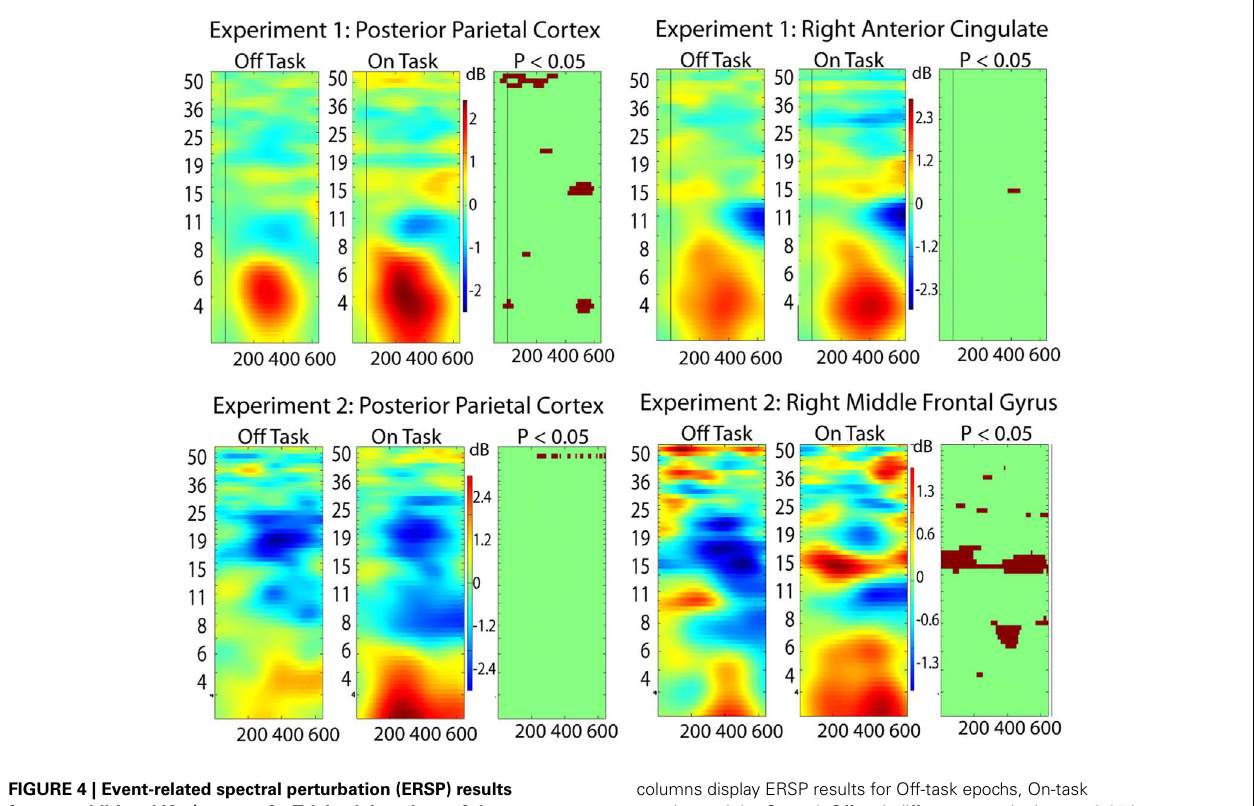
columns display ERSP results for Off-task epochs, On-task epochs, and the On-task Off-task difference masked at p = 0.05 by permutation